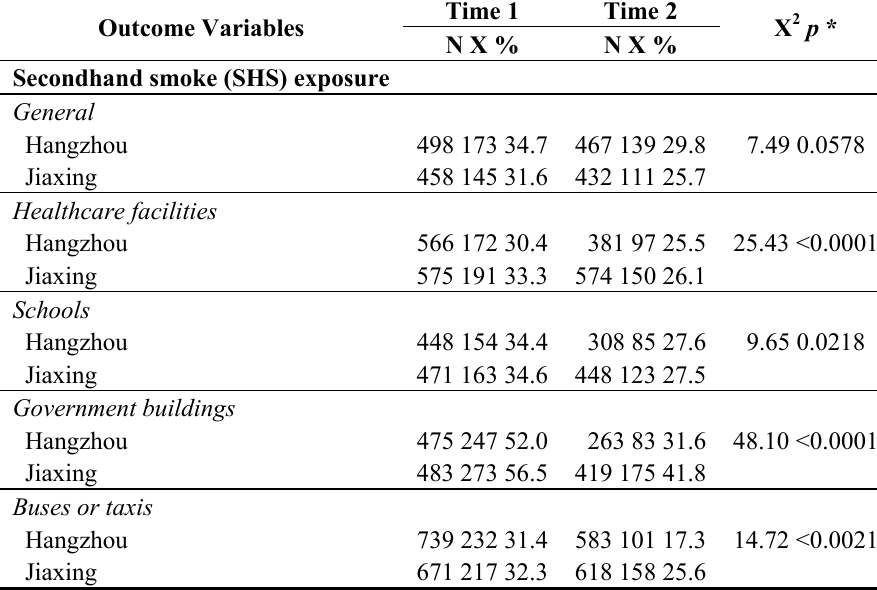
Table 2. Smoking and tobacco control variables by time of